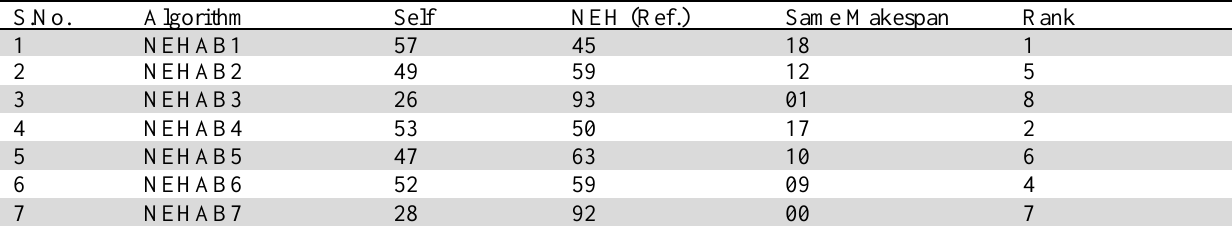
Individual Performance based on the Number of Instances